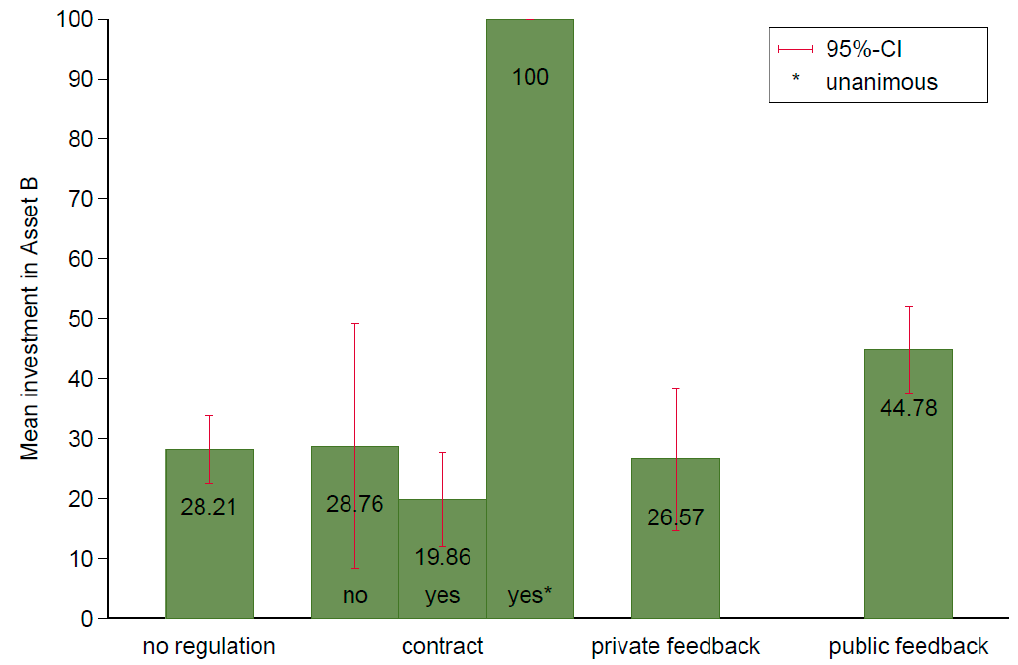
Figure 3. Mean investment in Asset B.